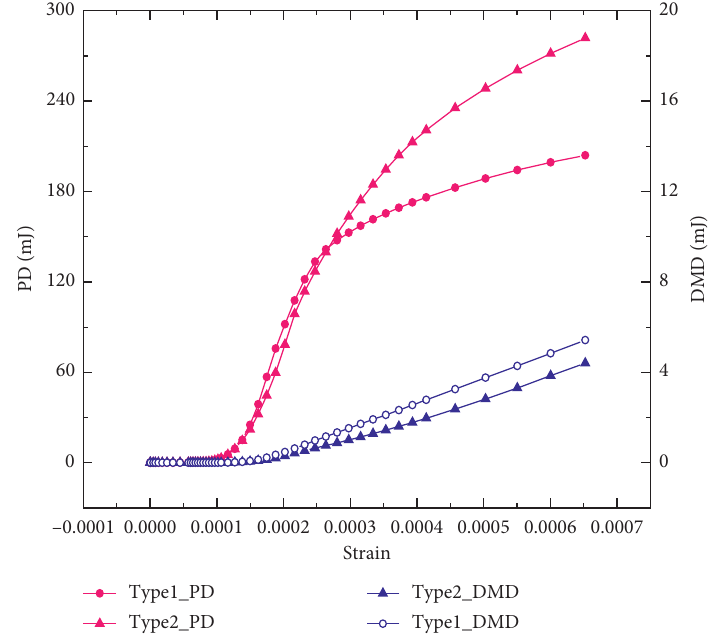
Figure 18: Energy-strain curves of the type I crack and type II